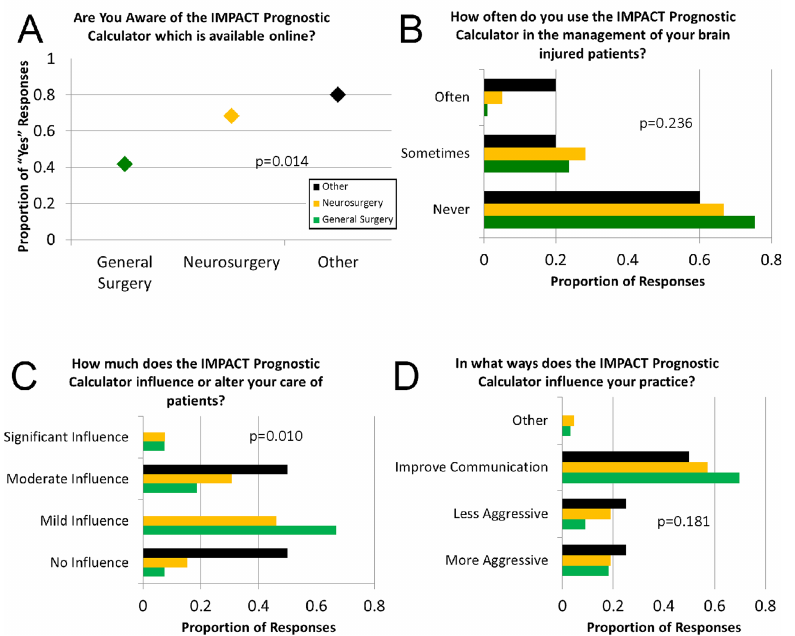
Fig 2. Responses to survey questions 12, 13, 14, and 15 (S1 Survey, Supplemental Digital Content 1) are presented in A, B, C, and D, respectively. Generalsurgeons returneda larger number of survey responses (109), neurosurgeons returned37 responses; the remaining practitioners(neither GS nor NS) returned7 surveys. A) The proportionof respondents that reportedawarenessof the IMPACT